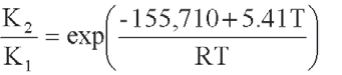
/P ratio on temperature and P O2 S2